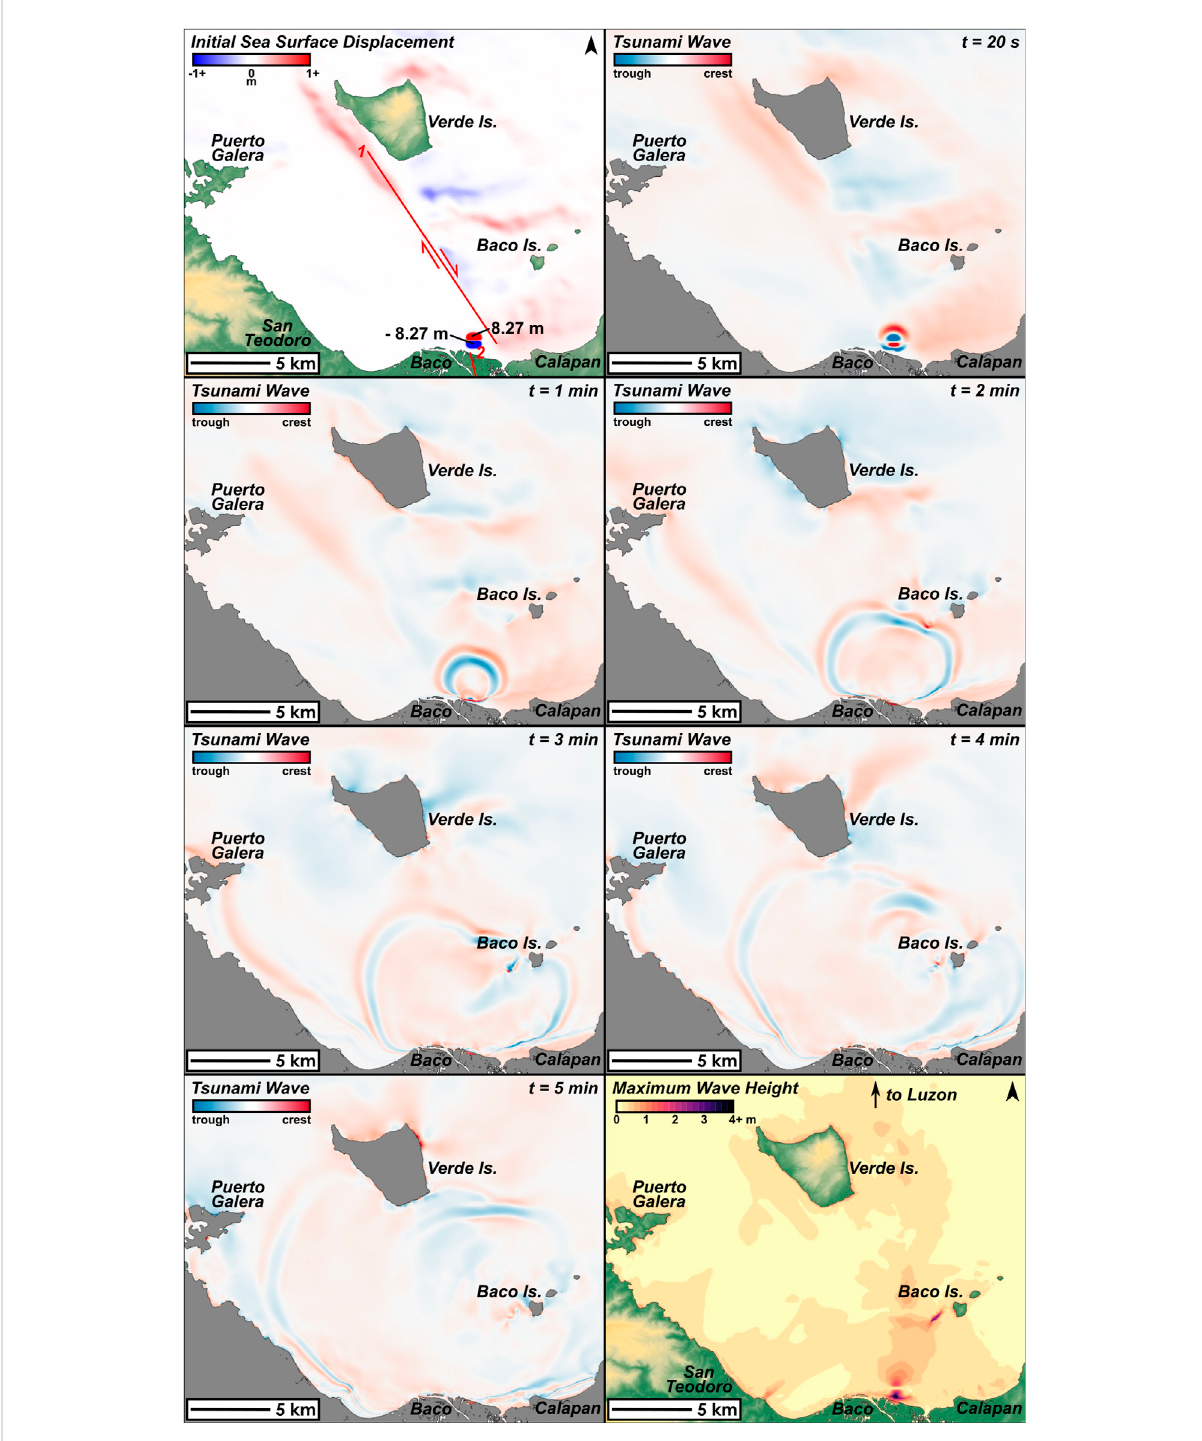
FIGURE 7 Initial sea surface displacement, tsunami propagation, and maximum wave height distribution of the EQ+SMF model. The Aglubang River Fault is shown in red, segmented into two sub-faults as described in Table 5. The amplitudes of the SMF-generated wave crests and troughs are also labeledaccordingly.Inthelastpanel,notethefocuseddistributionofextremewaveheights( > 4 m)atBacoandBacoIslands,whichisconsistentwith observed data, and is absent in the EQ-only